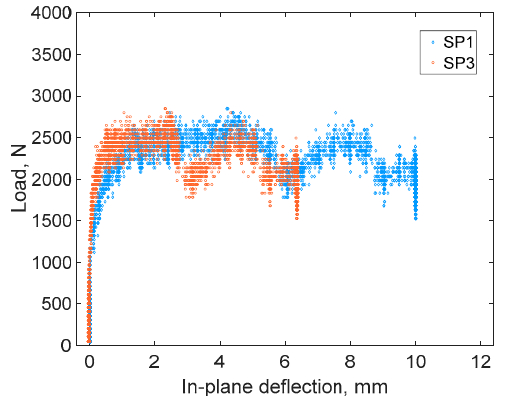
Figure 7. In-plane displacements of Wall 2.